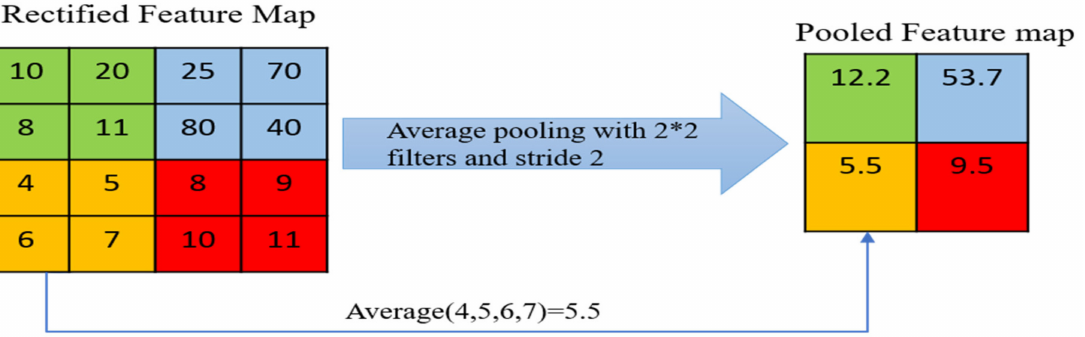
Figure 3. Common pooling method